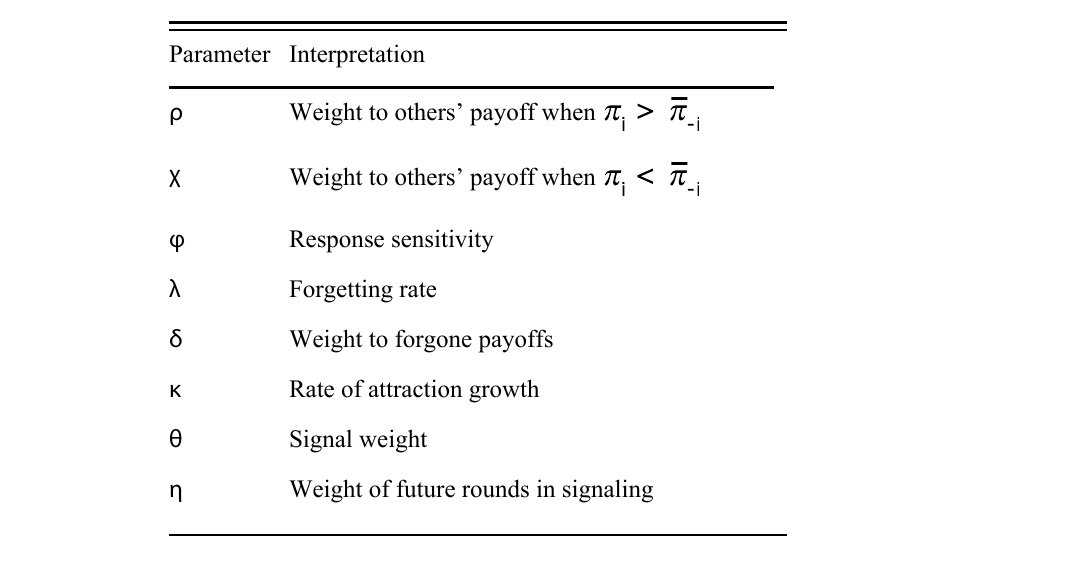
Table 2 . Parameters of the